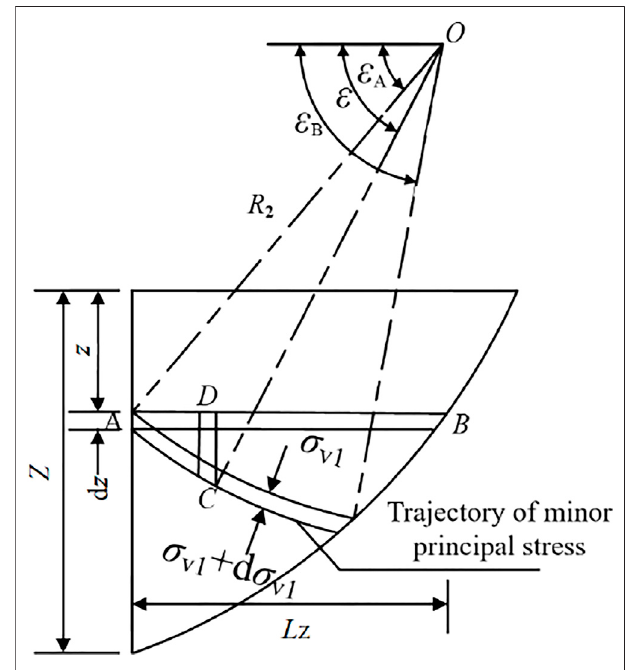
FIGURE 4 | Trajectory of minor principal stress of Zone